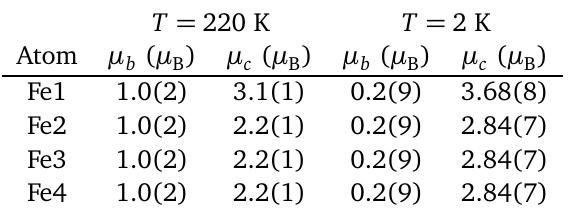
Table 3: Refined magnetic parameters of the magnetic structure at 220 K and of the commensurate spin component at 2 K. The components µ the refined parameters v and w shown in Table 2. The numbering of Fe atoms is analogous to Table